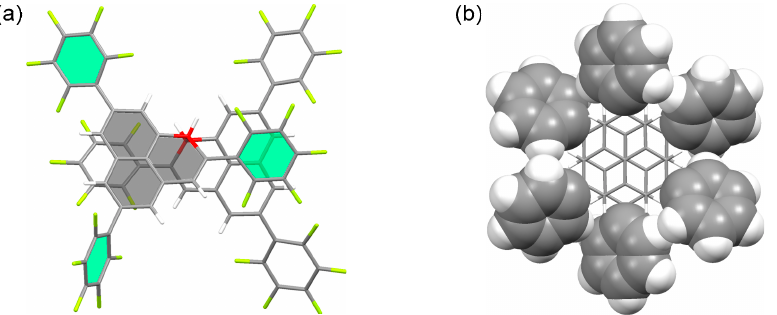
Figure 5. Attractive interactions between radical units of ( a ) 4 2 and ( b ) 5 2 .